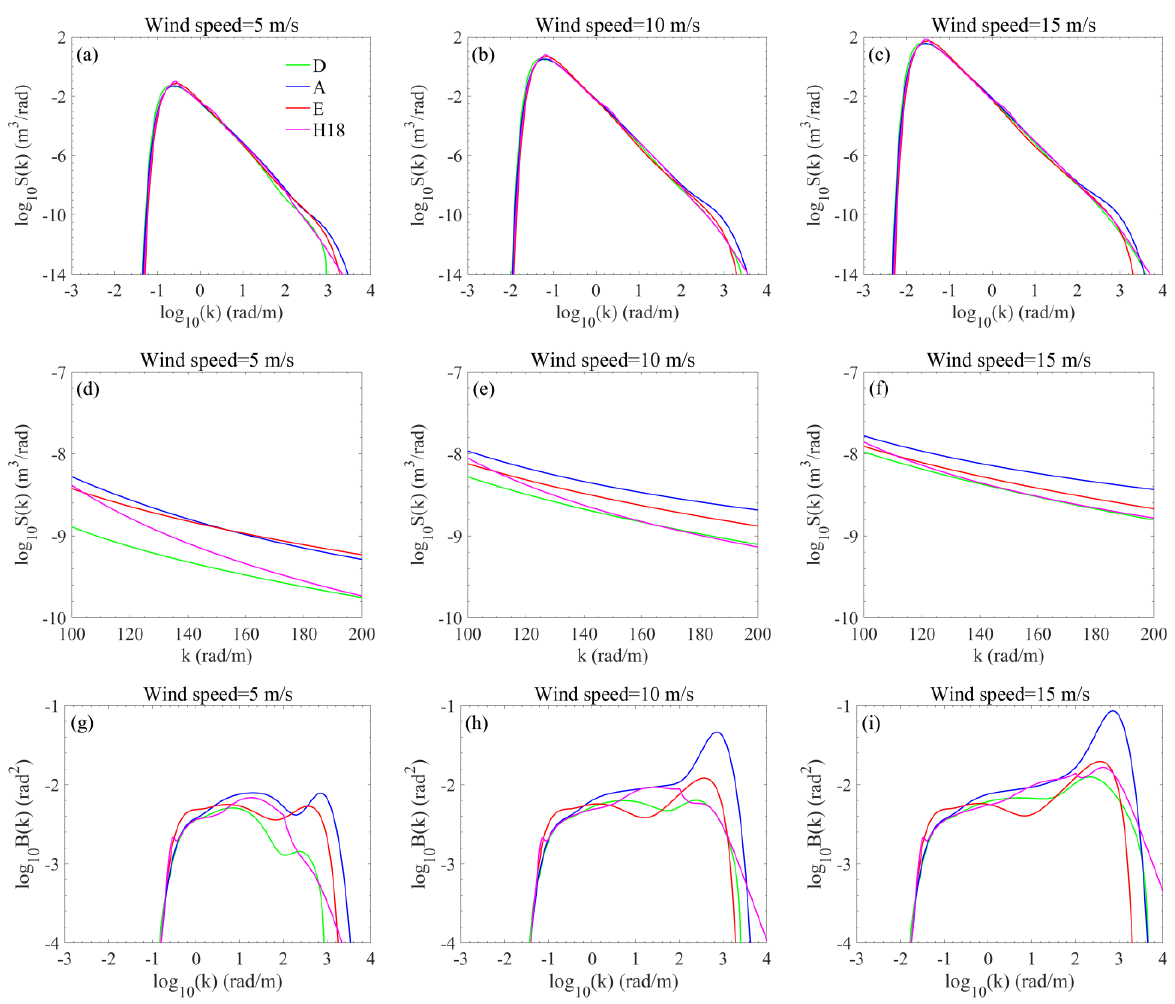
Figure 1. The variation of D, A, E, and H18 omnidirectional spectra S ( k ) and curvature spectra B ( k ) with wavenumber k at wind speeds of 5 m/s, 10 m/s, and 15 m/s. ( a – c ) Omnidirectional spectra vary with wavenumber k, ( d – f ) omnidirectional spectra that account for Bragg scattering for incidence angles between about 30 ◦ and 60 ◦ in the C band, ( g – i ) curvature spectra vary with wavenumber k. Green curve, D spectrum; blue curve, A spectrum; red curve, E spectrum; magenta curve, H18 spectrum.